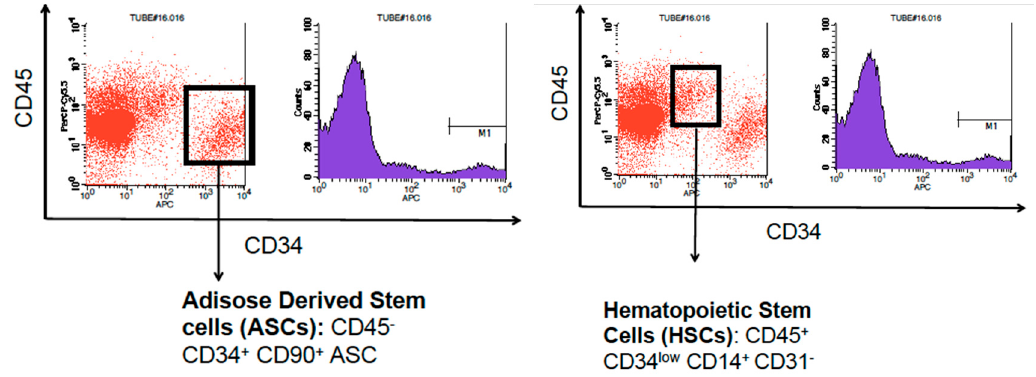
Figure 1. Flowcytometry analysis of stromal vascular fraction shows the presence of adipose derived stem cells characterized by CD45 - , CD34 + , CD90 + cell surface markers and hematopoietic stem cells characterized by CD45 + , CD34 low , CD14 + , and CD31 - cell surface markers.